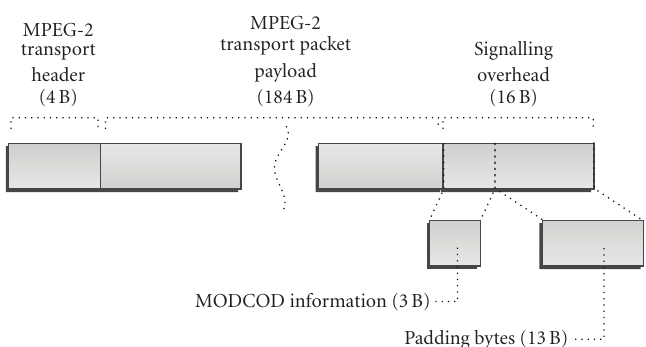
Figure 5: Modified Transport Packet sent to the Modulator, containing ACM/MODCOD signaling.